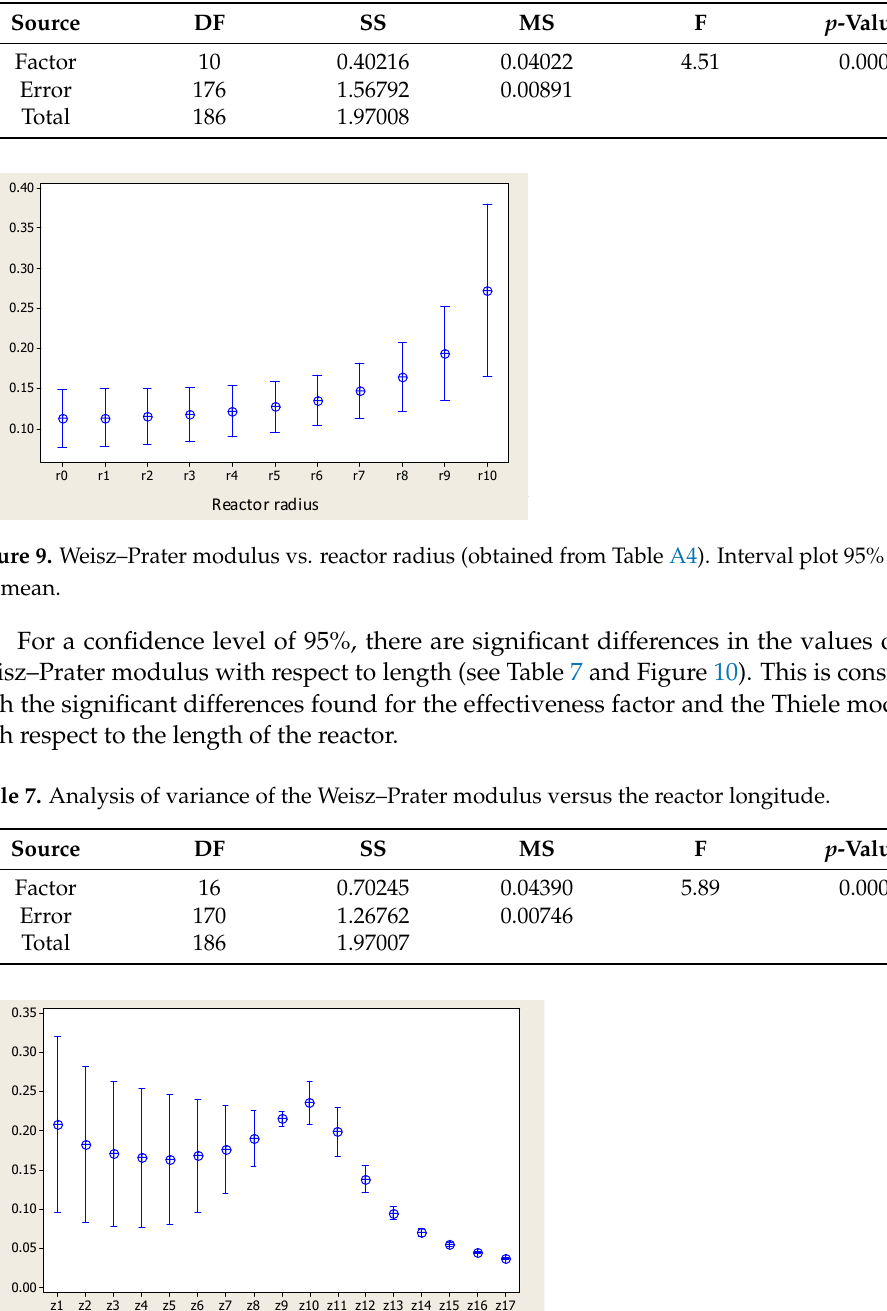
Table 6. Analysis of variance of the Weisz–Prater modulus versus the reactor radius.